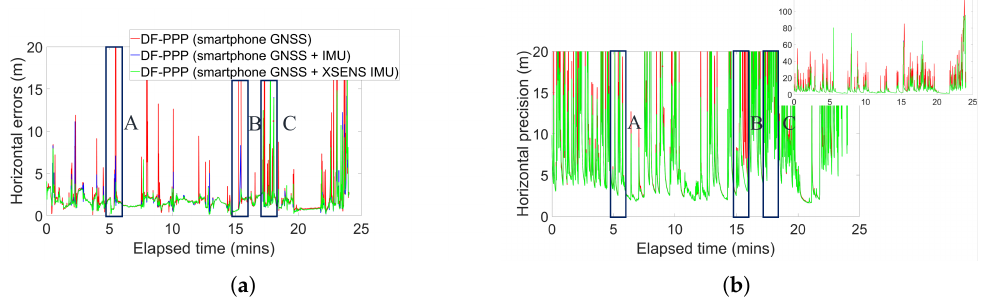
Figure 8. Horizontal error with respect to the reference trajectory and filter estimated precision comparison for dual-frequency PPP processing using smartphone GNSS measurements, GNSS+IMU measurements, and GNSS and Xsens IMU measurements. ( a ) Horizontal position error. ( b ) Horizontal precision